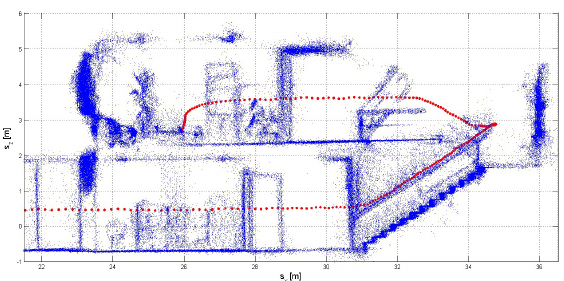
Figure 10: Side view of 3D point